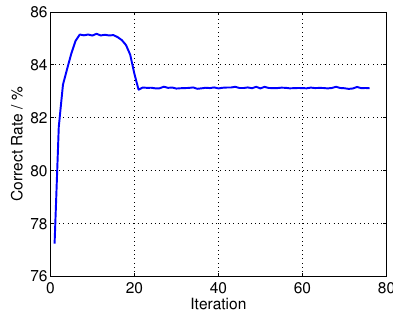
(a) Number of samples per class (class is colour coded) for each of the first 23 iterations. The graph of the sixth class of this set is omitted for better visualisation, it con- verges immediately. Figure 9: Degeneration of classes. (a) shows the important section for the number of samples per class. (b) depicts the classification